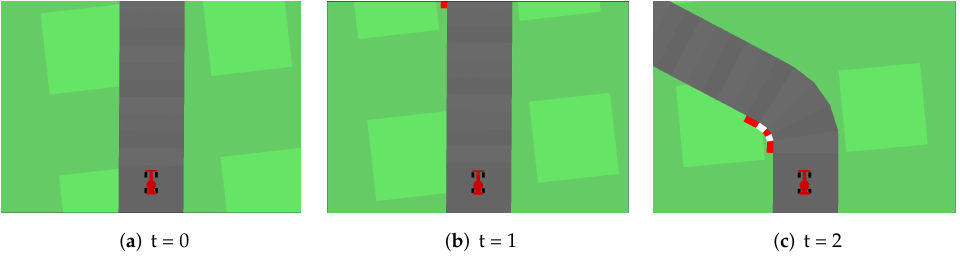
Figure 3. The input is represented by three consecutive images of 96 × 96 (matrix of 96 × 96 × 3) from the car racing game. The images in the figure are examples since they were previously processed in a gray